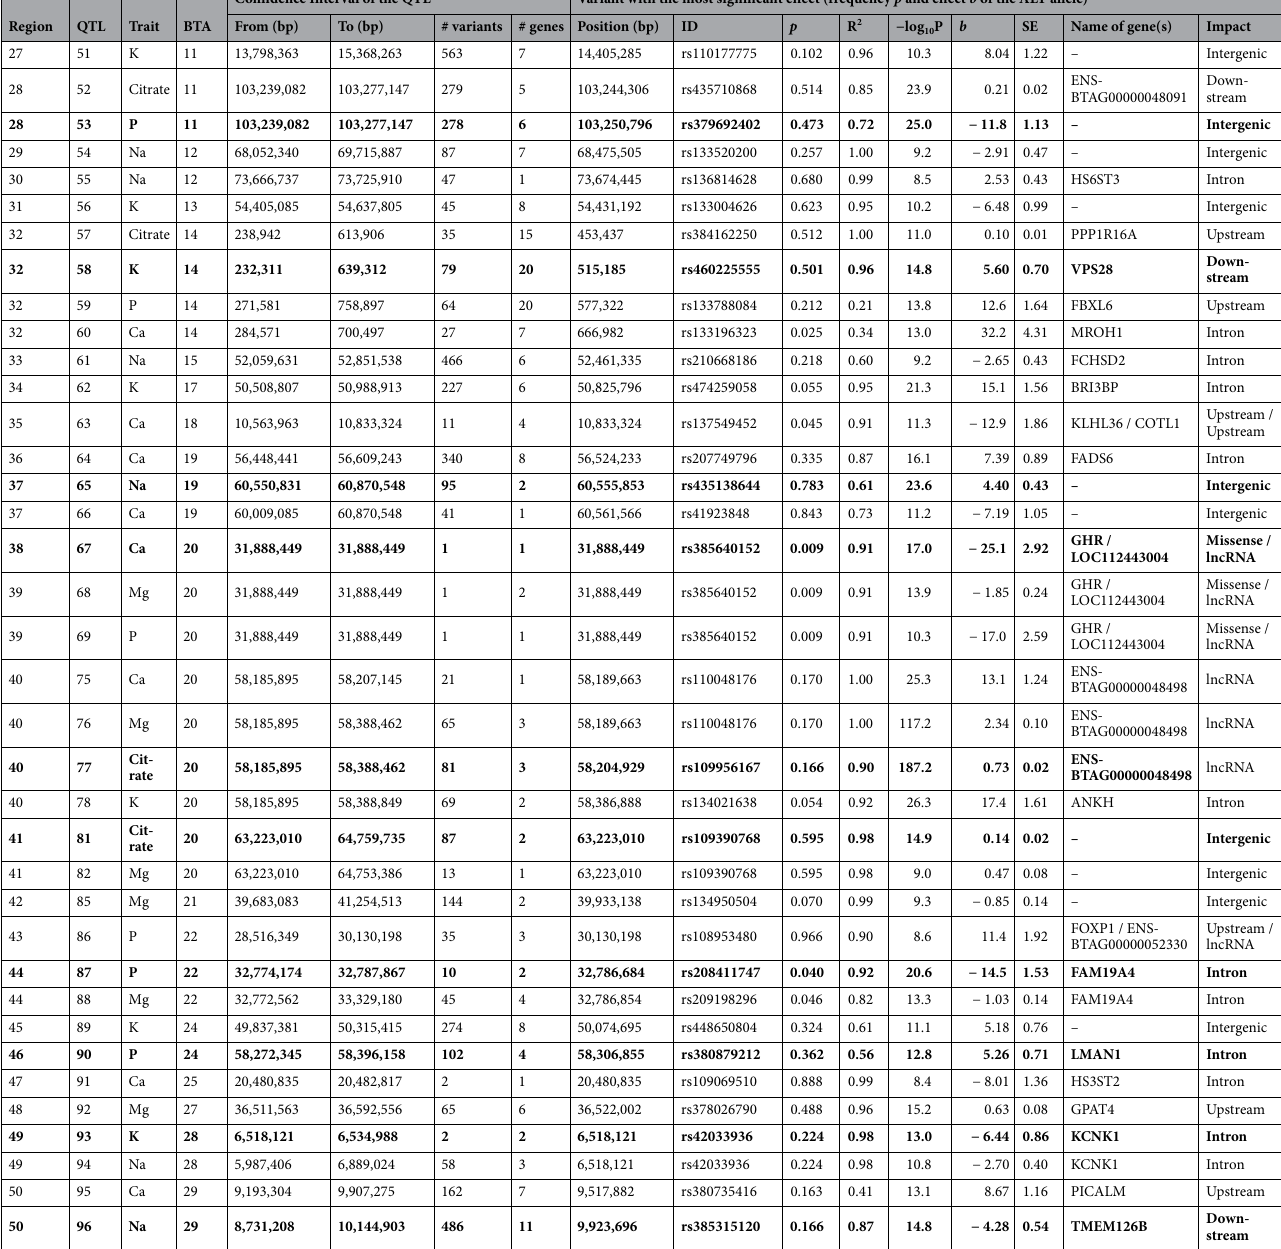
Table 4. QTL identified for milk mineral and citrate content on Bos taurus (BTA) autosomes 11 to 29 (when a QTL affected multiple traits, the most significantly affected trait is indicated in